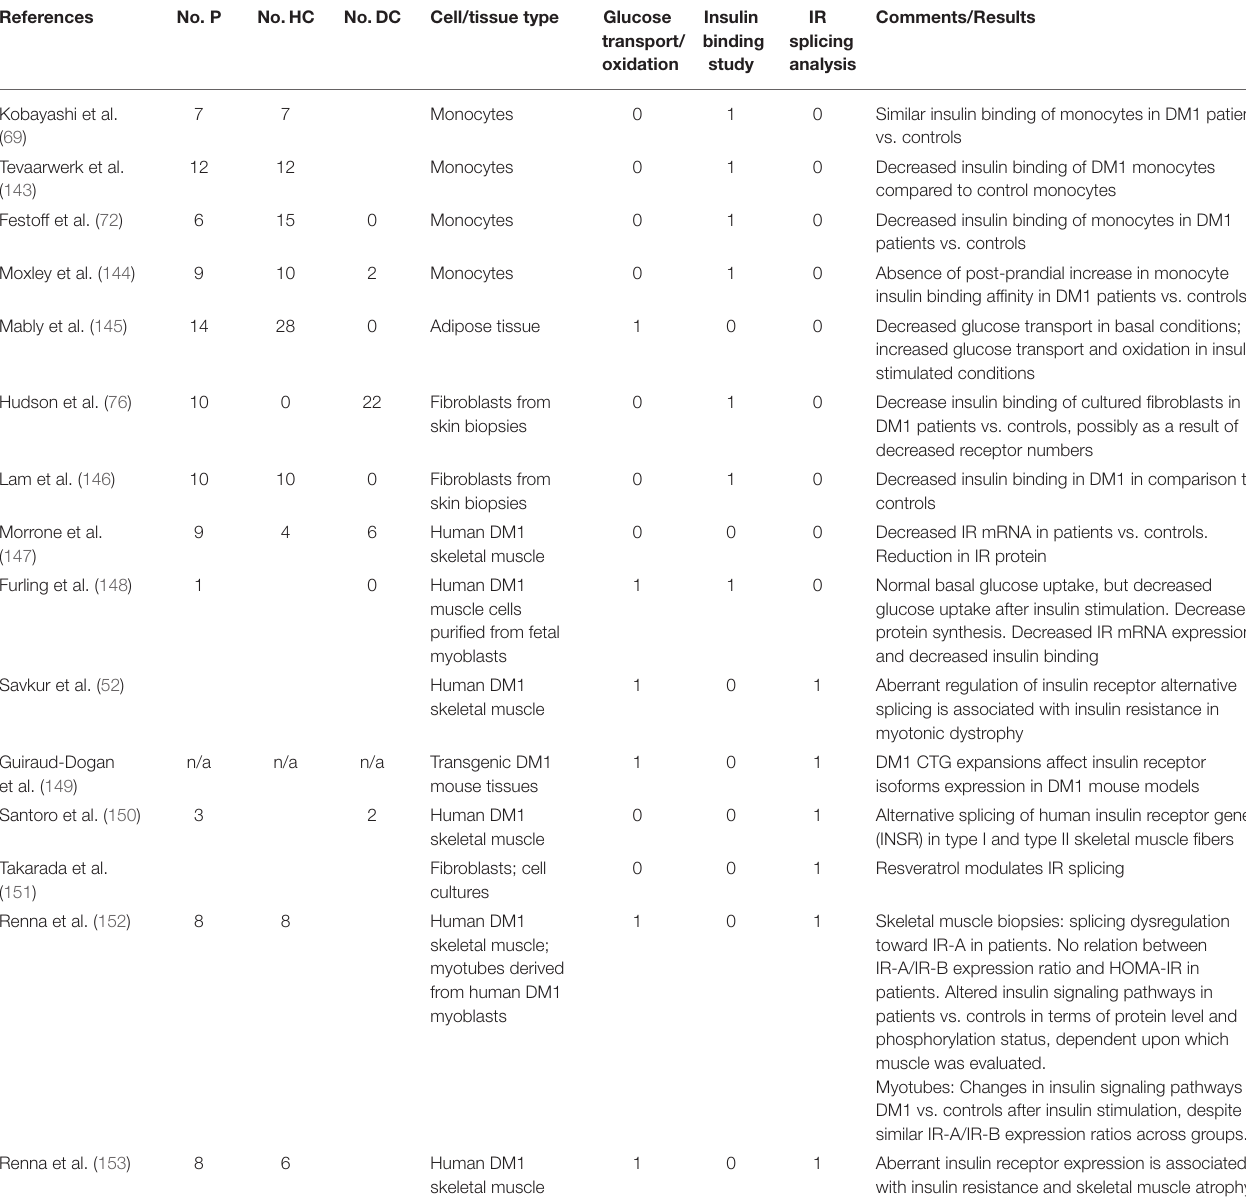
TABLE 2 | Molecular insulin studies in myotonic dystrophy type